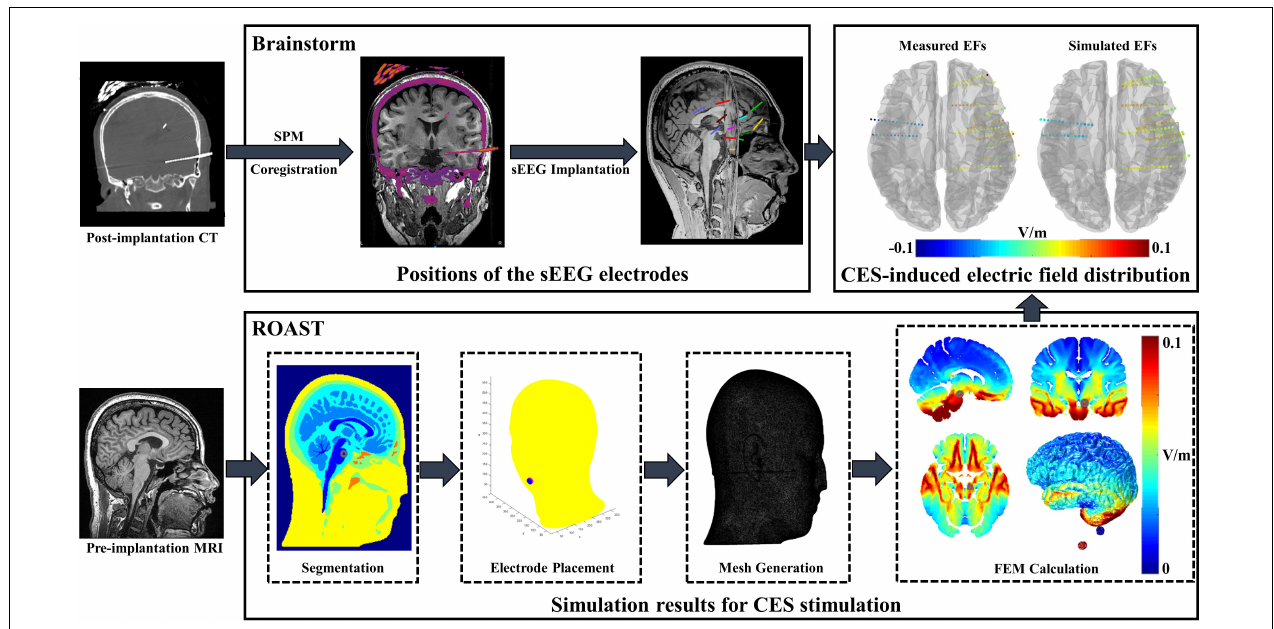
FIGURE 1 | Electric field (EF) modeling and in vivo data analysis procedure. Brainstorm software was applied for individual post-implantation CT/pre-implantation MRI image registration. After manually editing the sEEG electrode site on the original CT, the positions of the electrode were exported in the MNI coordinates. ROAST was adopted to perform EF modeling by using individual MRI image. The voxel coordinates of the stimulation electrode were imported to ROAST, and then the stimulation electrodes were modeled at the customized locations. Combining with the simulated results and MNI coordinates of sEEG electrode, the voltage values of each electrode site were obtained and further compared with the measured